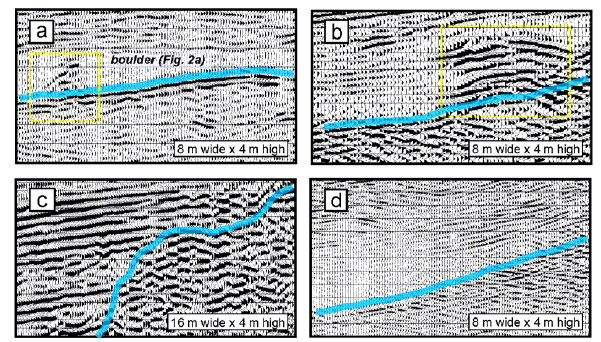
Figure 8: Details from characteristic basal structures displayed as migrated sections. (a) Transition from ice to fine-grained sediment (Figs. 2a, 3). The reflective zone in the left part originates from a large boulder. (b) Transition from ice to either debris or jointed bedrock. The reflection signature is generated by large boulders (Fig. 2b). (c) The situation shown in Fig. 6 exhibits a base characterized by the termination of internal layers. The incoherent returns from the base originate from either debris or bedrock. (d) A base characterized by a sudden increase in reflectivity (see also Fig. 7). In the right part base parallel internal layers near the basal zone are visible.